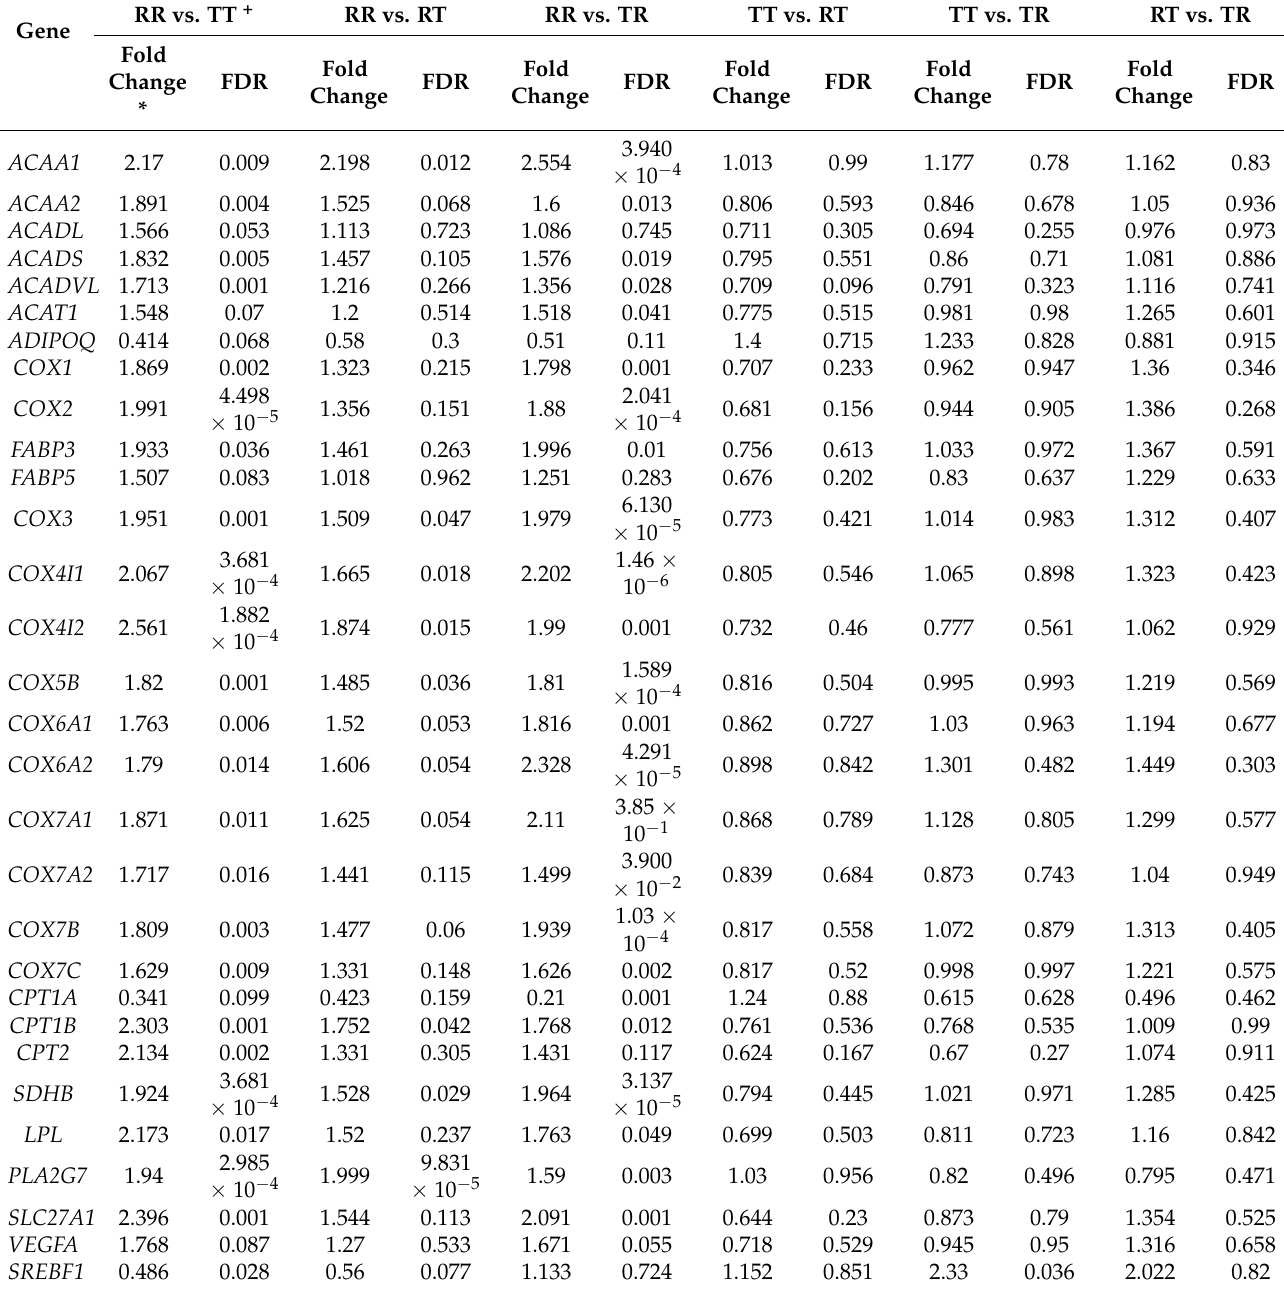
Table A2. Fold change and FDR of differentially expressed genes relevant for the lipid’s metabolism in the two studied varieties and reciprocal